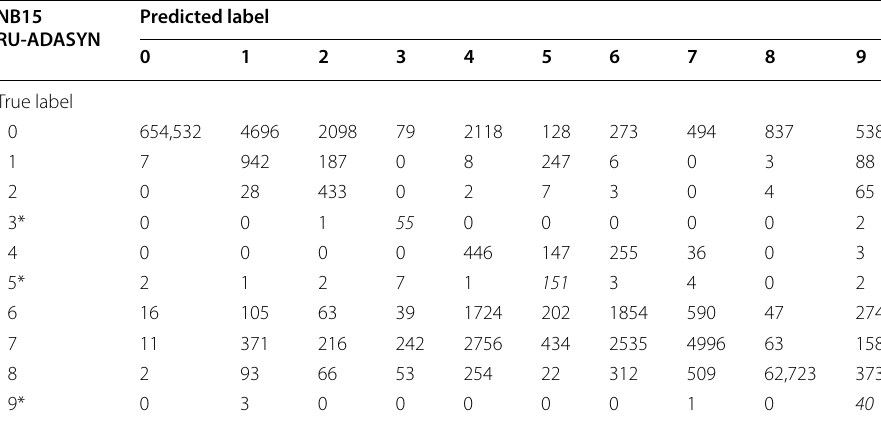
Table 27 Confusion Matrix: NB15 RU-ADASYN NB15